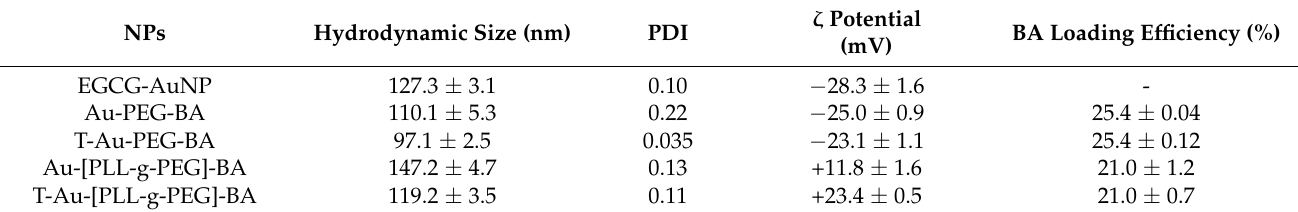
Table 1. Hydrodynamic size, zeta potential ( ζ ), polydispersity indices (PDI) and drug loading efficiencies of nanoparticles. NPs Hydrodynamic Size